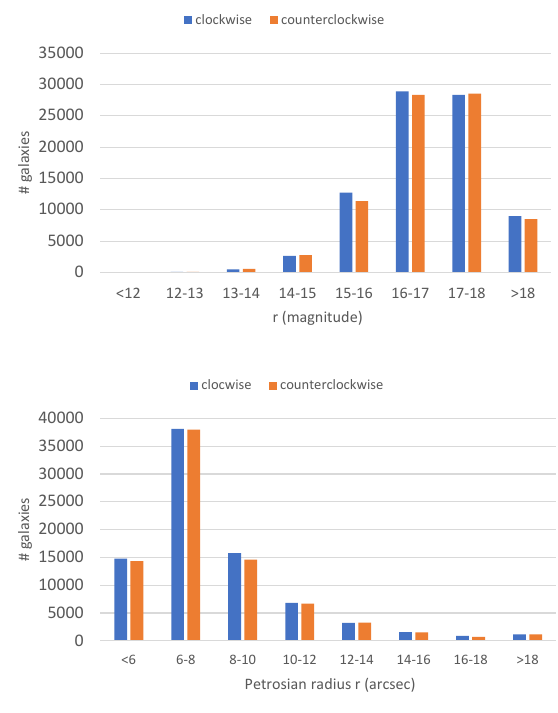
Figure 3. The distribution of clockwise and counterclockwise galax- ies in different r exponential magnitudes and Petrosian radii mea- sured on the r band.